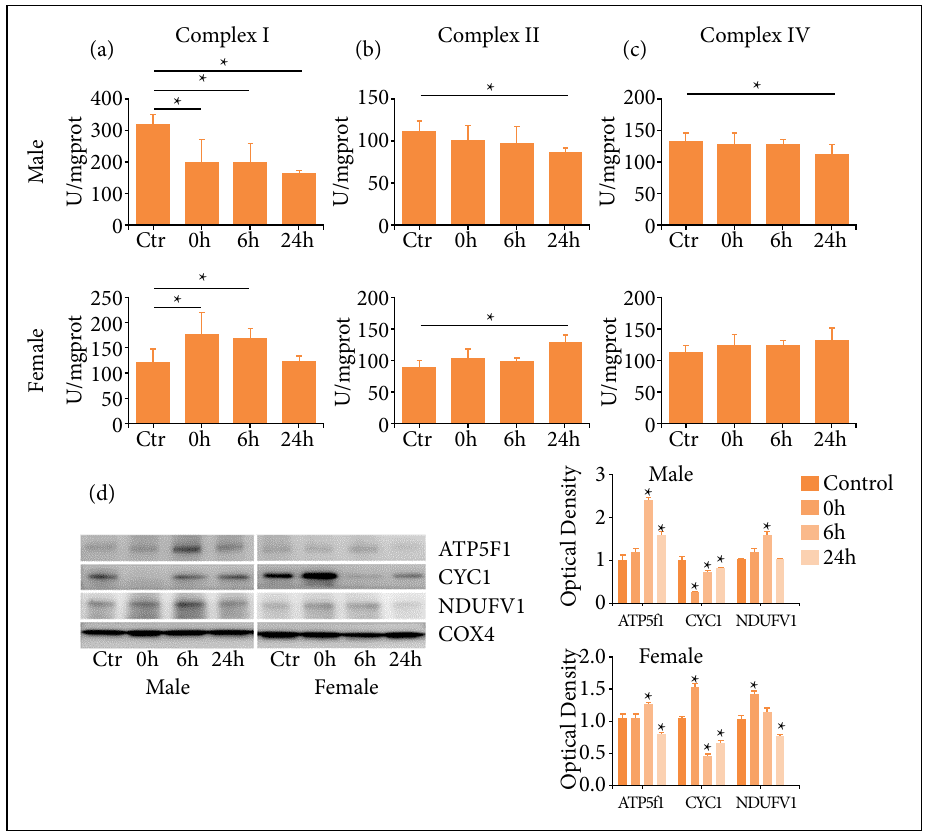
Figure 4 - One-time high-load exercise induce dysfunction of mitochondria; (a–c) Activities of mitochondrial complex I, II and IV; (d) Differential expression of mitochondrial proteins. * p < 0.05 compared with the control